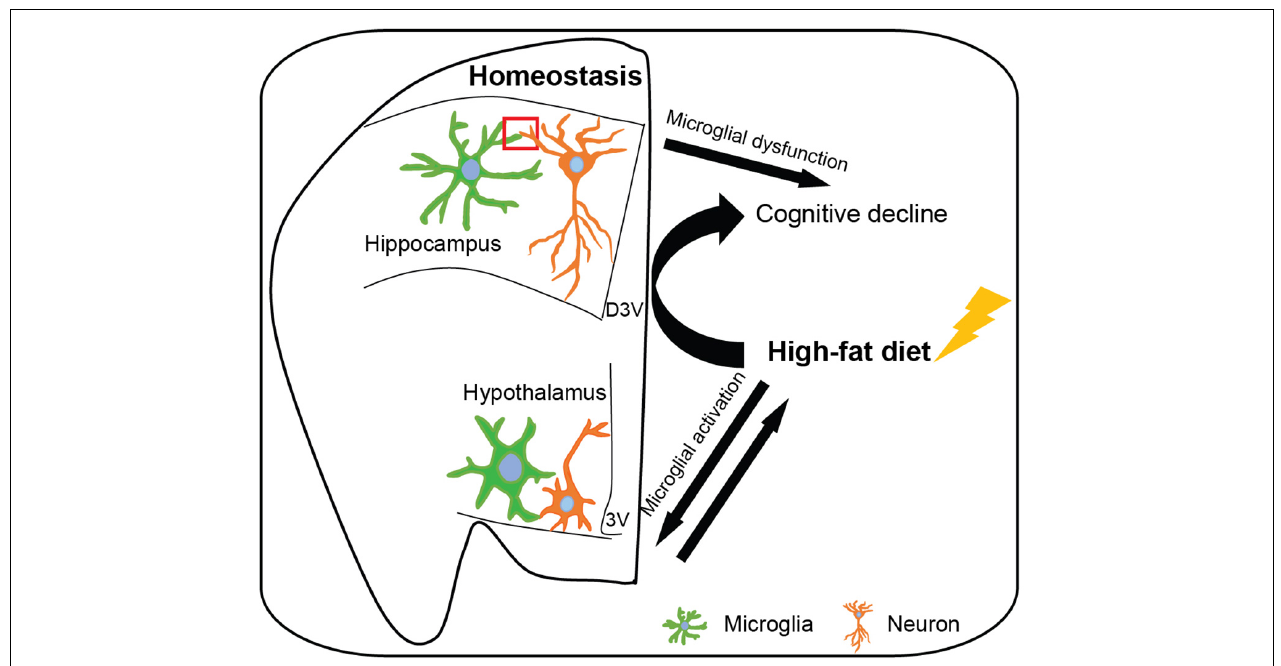
FIGURE 1 | Microglia affect hippocampal and hypothalamic neuronal circuits in homeostatic and high-fat diet-induced obese conditions. In the homeostatic brain, microglia survey the surrounding microenvironment and interact with neurons to shape neuronal circuits, including synaptic phagocytosis, engulfment of unwanted cells and debris, synaptic formation, neurogenesis, secretion of soluble factor, and expression of inducible receptors. Hippocampal microglia participate in synaptic remodeling during the cognitive process and hypothalamic microglia regulate energy homeostasis, however, microglial dysfunction leads to cognitive decline and obesity, respectively. Moreover, high-fat diet (induced obesity) results in hypothalamic microglial activation which may exacerbate the progress of obesity. Additionally, high-fat diet-induced obesity activates hippocampal microglia and leads to cognitive decline. D3V, dorsal third ventricle; 3V, third ventricle.